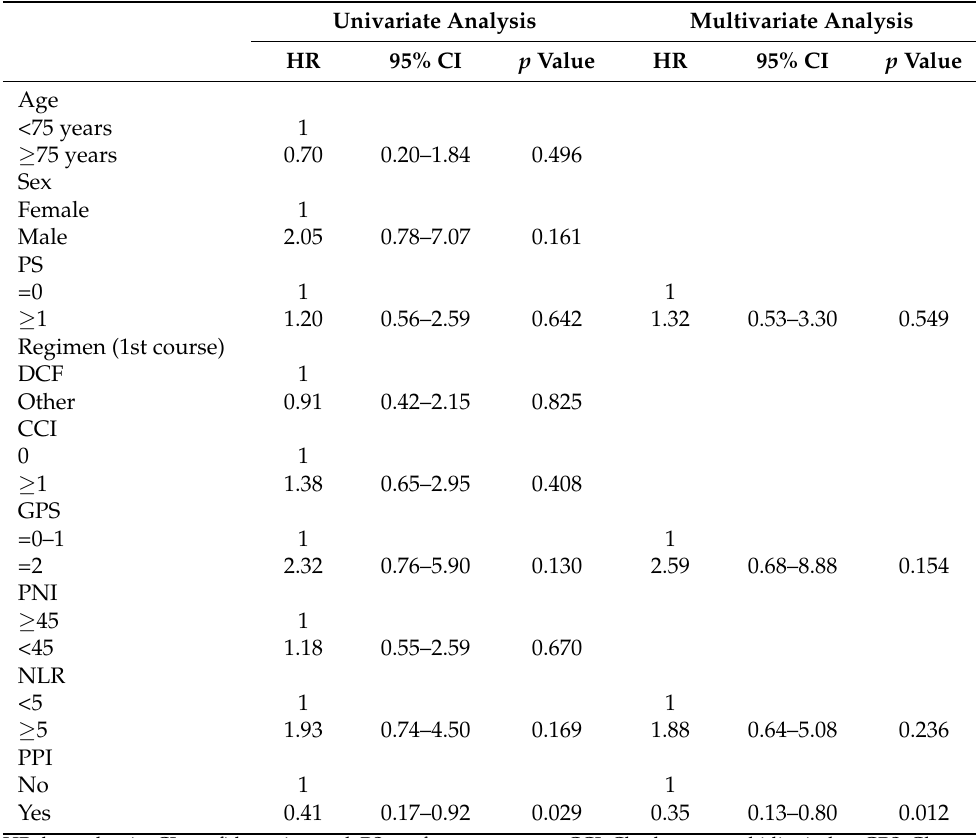
Table 3. Univariate and multivariate analyses of risk factors for overall survival in esophageal cancer patients treated with 5-FU-based chemotherapy.